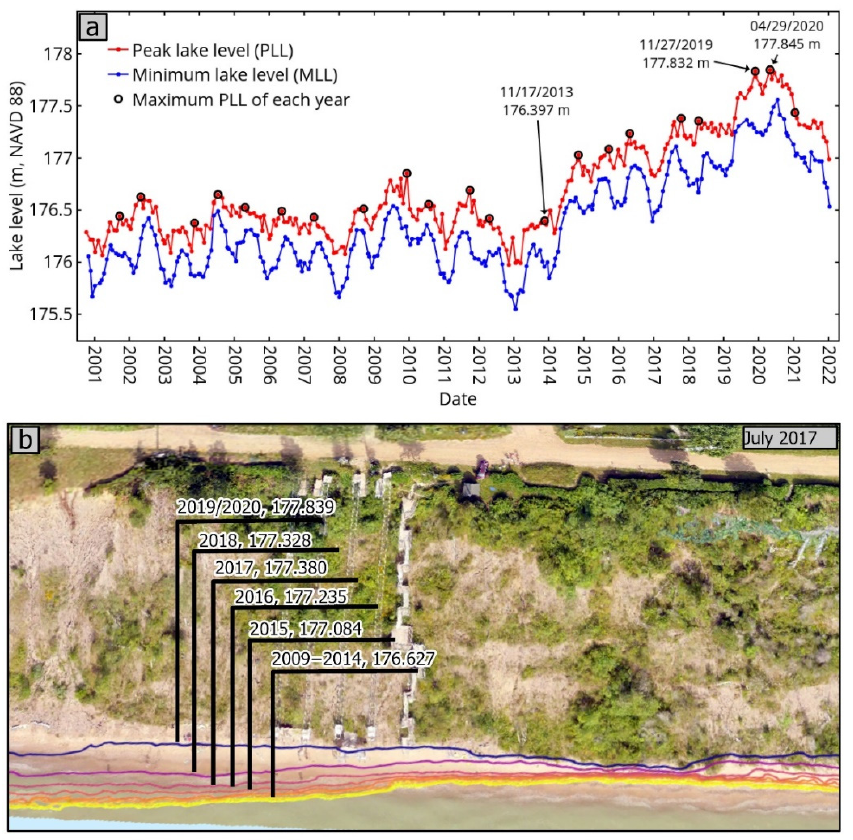
Figure 10. ( a ) Temporal records of PLL (red line) and MLL (blue line) LLs at the Holland station (Station ID: 9087031; https://tidesandcurrents.noaa.gov/waterlevels.html?id=9087031 [accessed on 5 January 2022]). ( b ) Contour lines for PLL for the years 2009 through 2020 overlaid onto the 2017 UAV image for the area outlined by a black box in Figure 8c. A unified vertical datum (NAVD 88) was applied for the PLL and MLL time series, and the PLL contour lines and the DEM over which the UAV image was draped (Figure